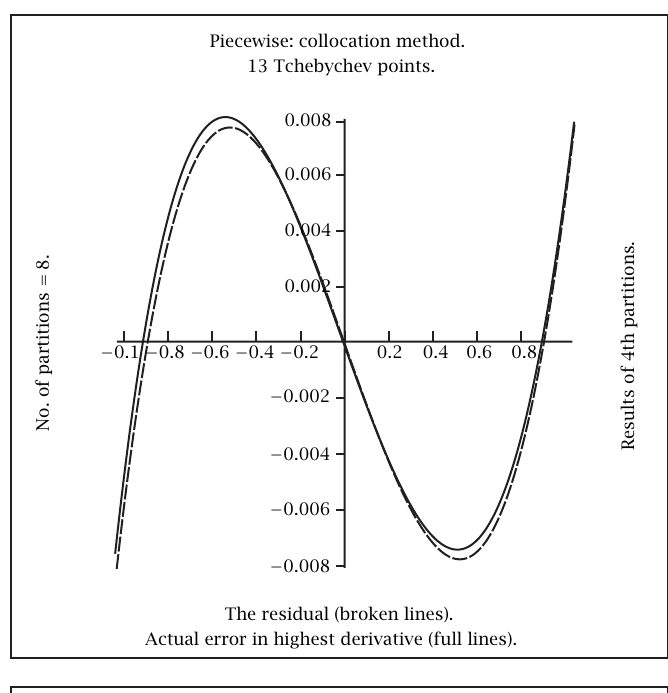
Piecewise: collocation method. 13 Tchebychev points.